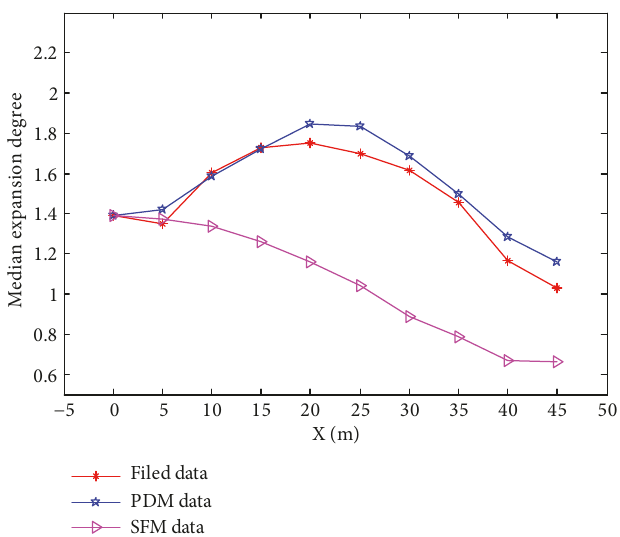
Figure 17: Median dispersion degree in each section at the Xianxia-Jianhe intersection.